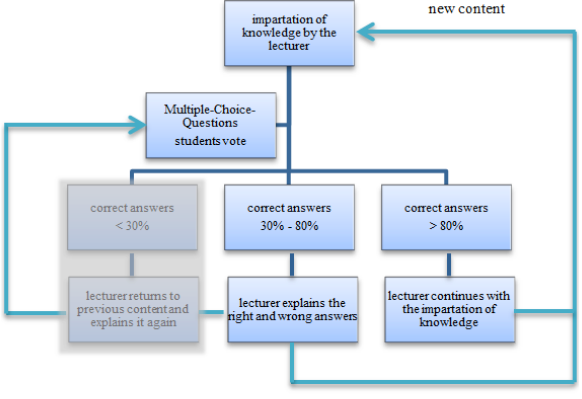
Figure 3. Didactical concept of using the ARS [23] Figure 3 illustrates the didactical concept of an Audi- ence Response System, which is treated in the ‘KOE’. Two fields are shaded grey, as this case is not applied in the lecture. If there are less than 30% correct answers, an explanation on the right answer is given. Provided that the content is understood (>80% correct answers), the lecturer switches to the next